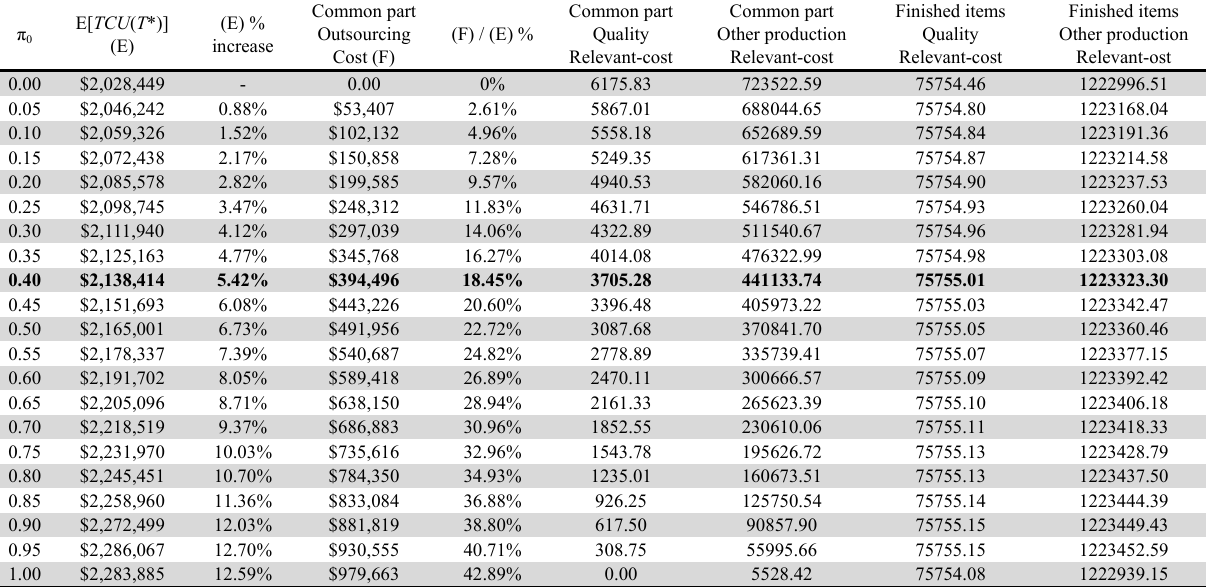
The impact of changes in π 0 on diverse system cost-relevant